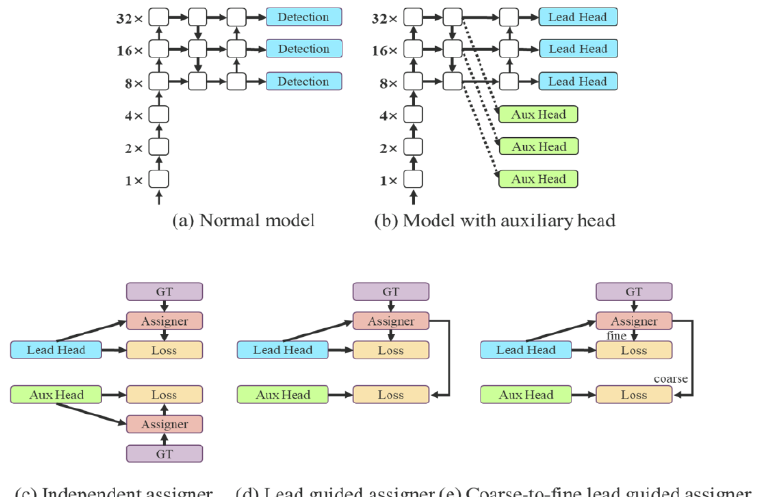
Figure 4. The YOLOv7 framework features a lead head and an auxiliary head that are guided by a